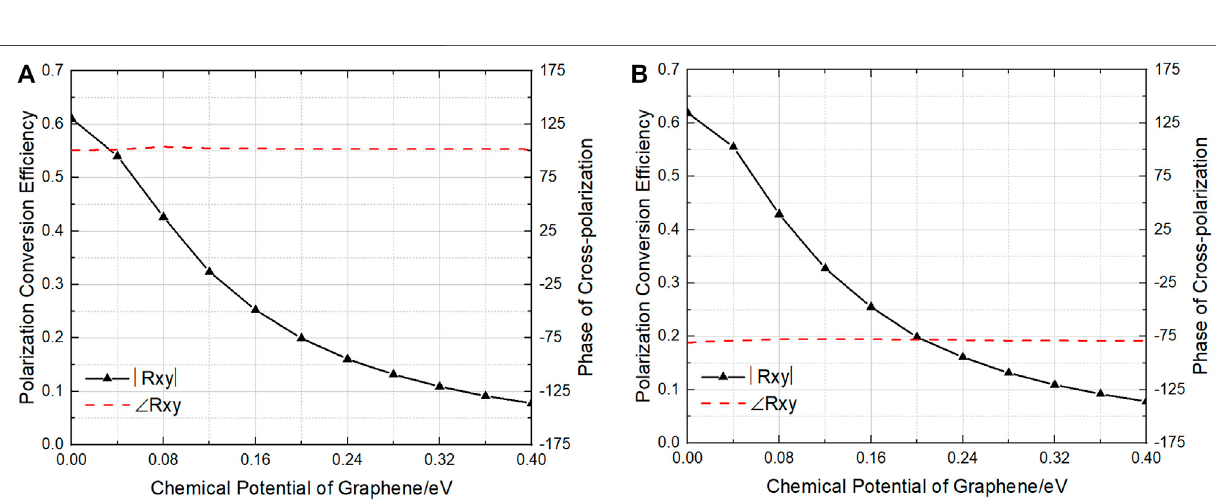
Frontiers in Materials |